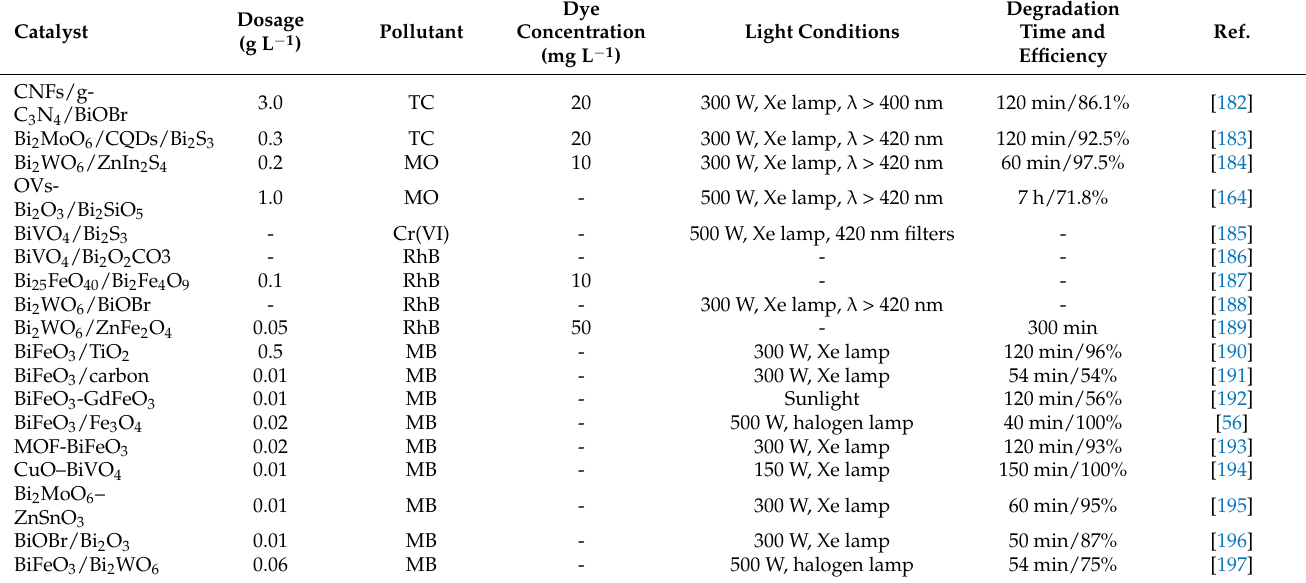
Table 1. Recent studies on nanostructured Bi-based photocatalysts for pollutant